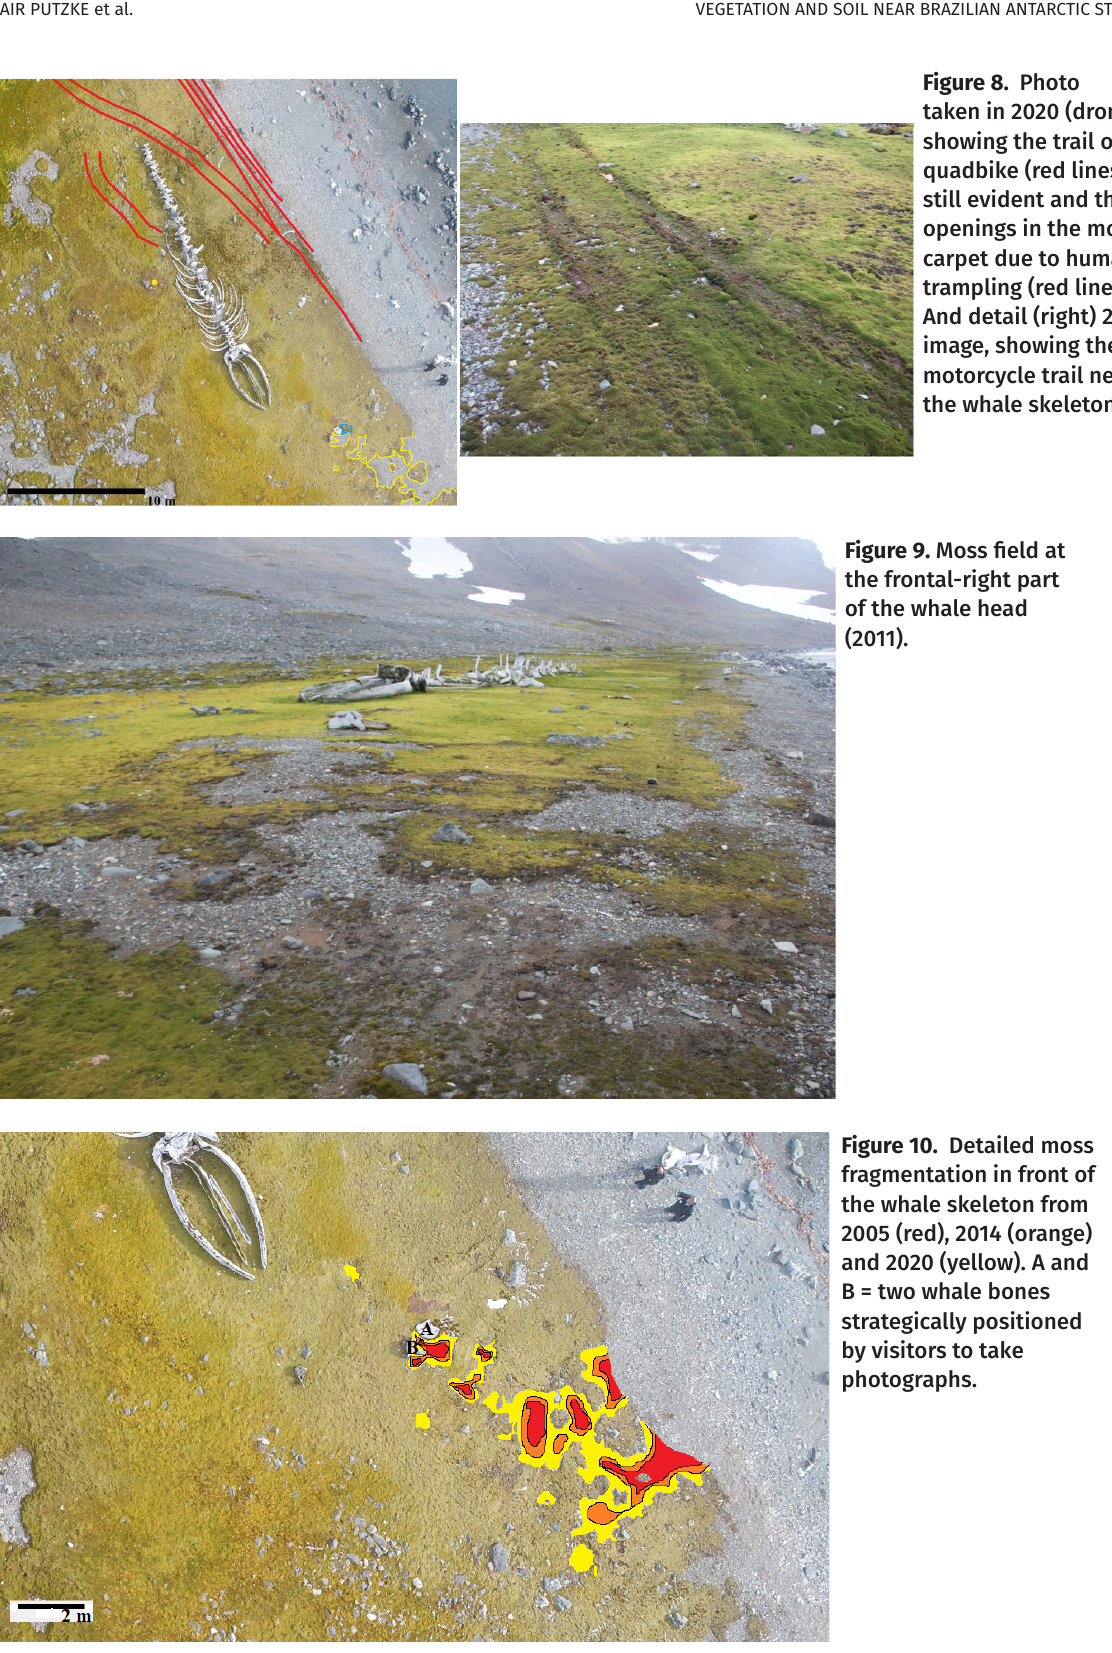
Figure 10. Detailed moss fragmentation in front of the whale skeleton from 2005 (red), 2014 (orange) and 2020 (yellow). A and B = two whale bones strategically positioned by visitors to take photographs.